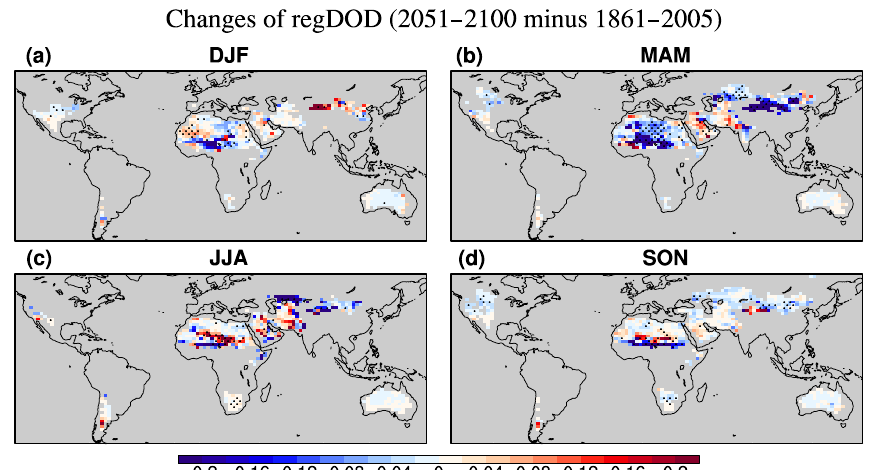
Figure 9. Projected change of DOD in the late half of the 21st century under the RCP8.5 scenario by the regression model. The results are calculated using the regression coefficients obtained from observations during 2004–2016 (see Sect. 2) and projected changes of precipitation, bareness, and surface wind from seven CMIP5 models. Dotted areas are regions with sign agreement among the regression projections (using output of each of the seven models) above 71.4% (i.e., at least five out of seven regression projections have the same sign as the multi-model mean projection). To highlight DOD variations near the source regions, a mask of LAI ≤ 0 . 5 (from present-day climatology) is applied.